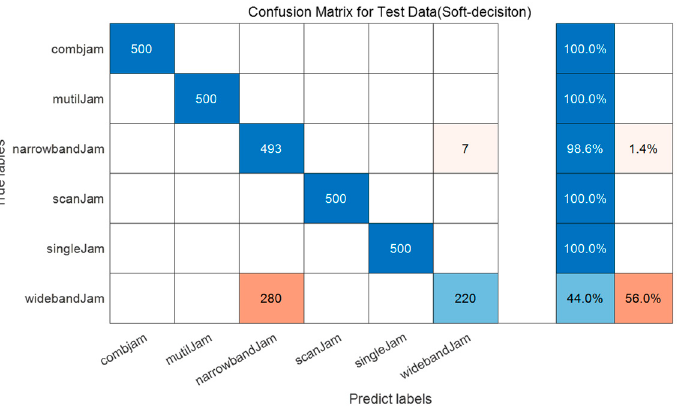
Figure 13. Confusion matrix of the hard-fusion based method (ResNet, the number of co-cognitive nodes is 6 under JSR = − 6 dB).